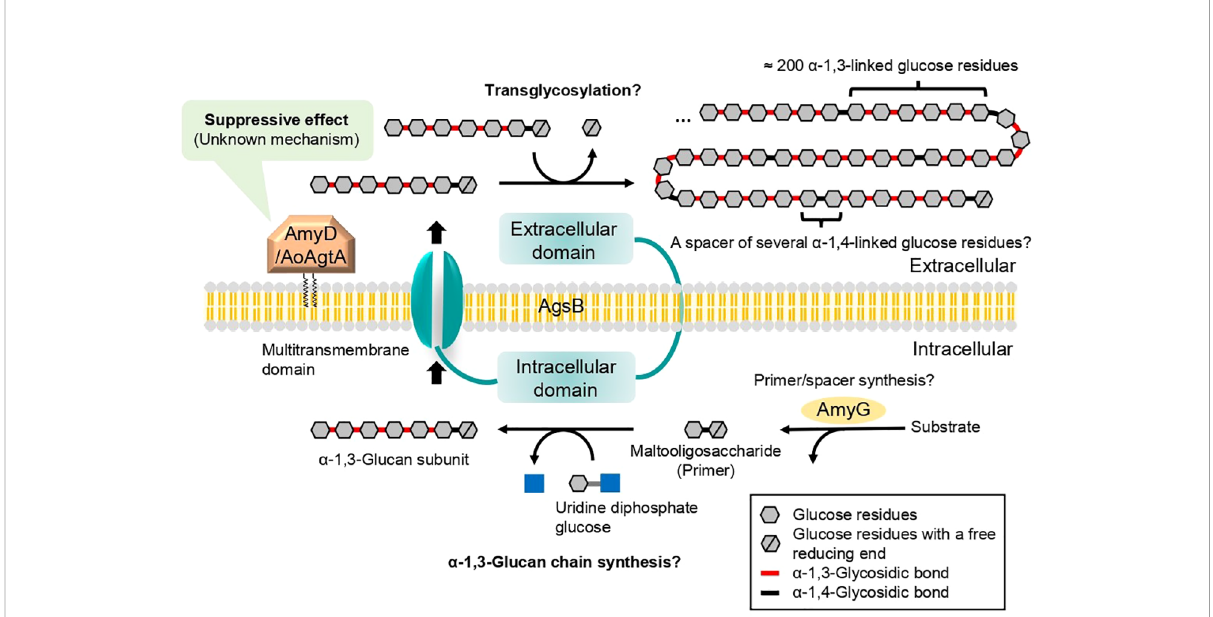
FIGURE 1 Speculative model for biosynthesis of cell wall a -1,3-glucan in A. nidulans and A. oryzae . Cell wall a -1,3-glucan is mainly synthesized by AgsB, which is composed of extracellular, intracellular, and multitransmembrane domains. Maltooligosaccharide is likely required as a primer for a - 1,3-glucan biosynthesis and may be produced by intracellular a -amylase AmyG. The a -1,3-glucan chains may be synthesized by the intracellular domain of AgsB, and the resulting a -1,3-glucan subunits may be exported extracellularly by the multitransmembrane domain. The a -1,3-glucan subunits may be linked by transglycosylation catalyzed by the extracellular domain of AgsB to complete a -1,3-glucan maturation. Glycosylphosphatidylinositol-anchored a -amylase AmyD/AoAgtA regulates cell wall a -1,3-glucan biosynthesis, but the underlying mechanism remains unclear. Question marks indicate steps that are not fi rmly